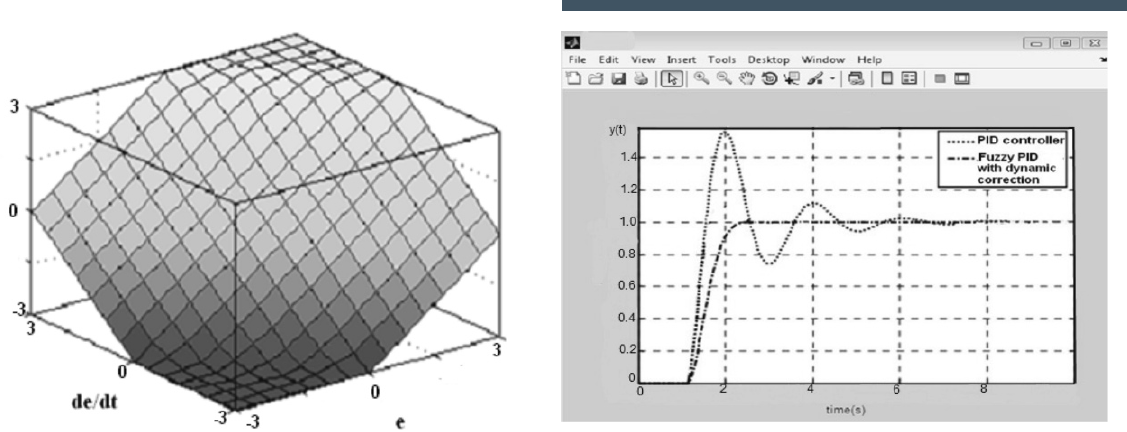
Figure 6. Control surface output variable obtained from the MATLAB model.